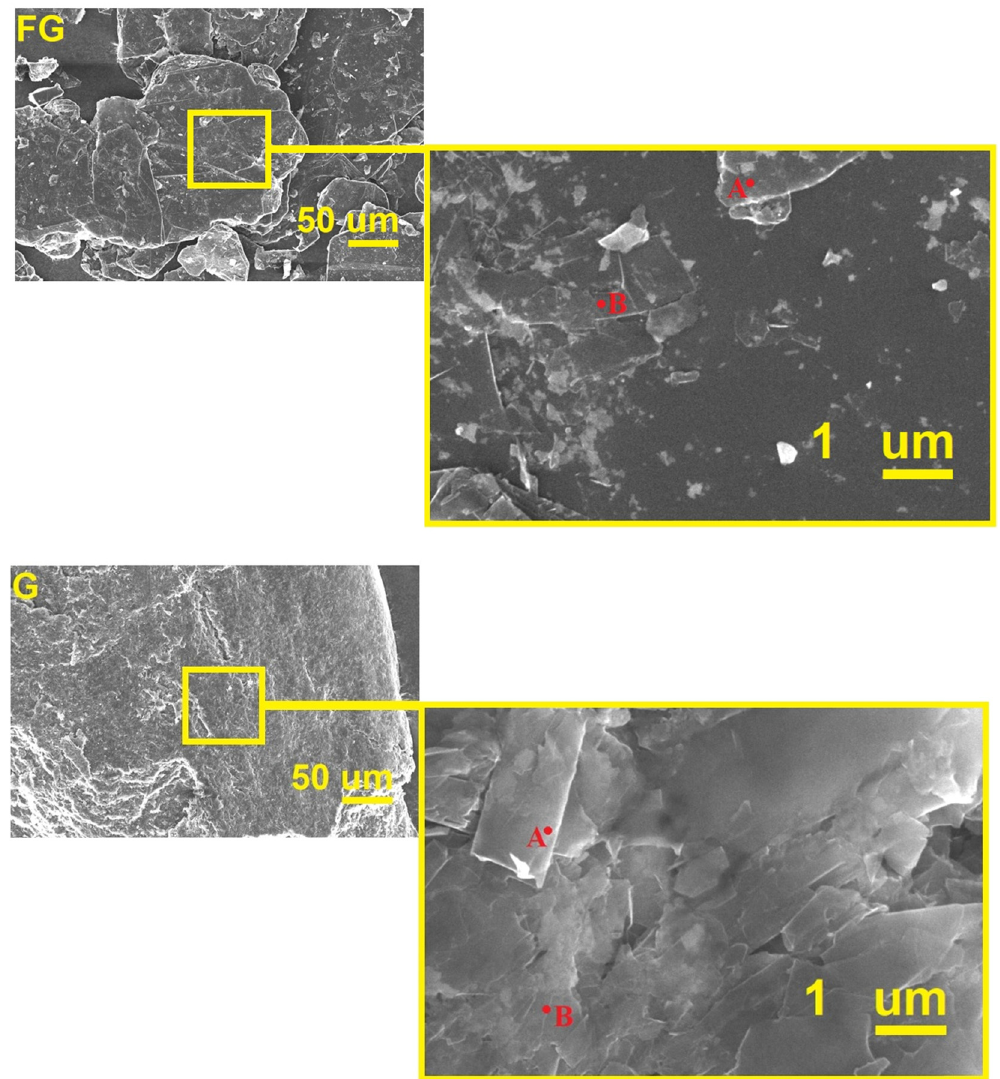
Figure 6: FESEM image for graphene and fl ake